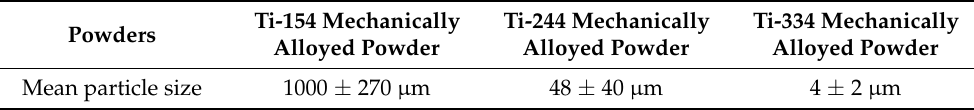
Figure 2. Morphology and particle size distribution of ( a ) Ti-154; ( b ) Ti-244; and ( c ) Ti-334 (magnified image is shown in inset) mechanically alloyed powders. Table 3. The average particle size of the mechanically milled powders.